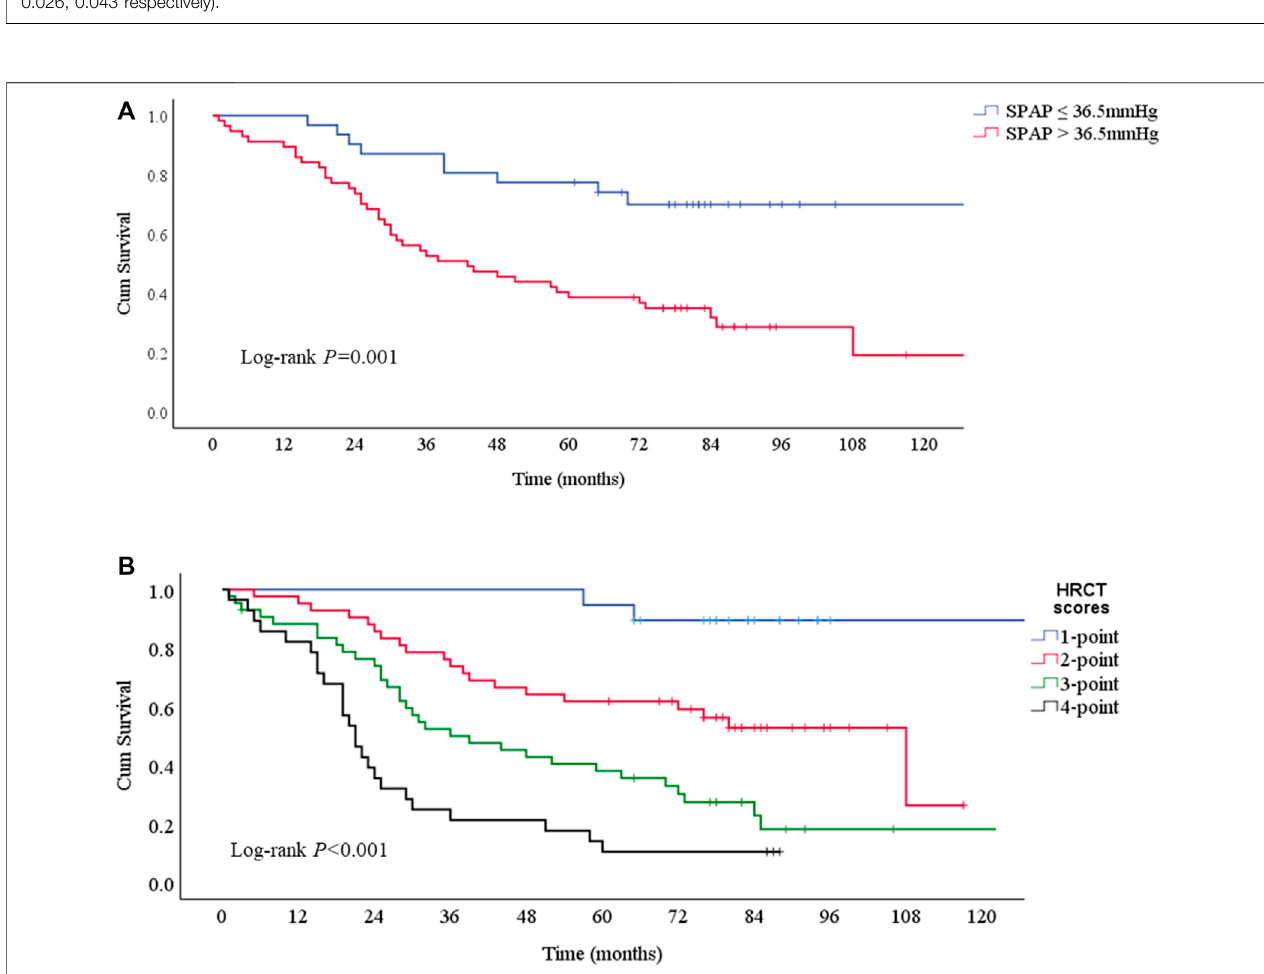
FIGURE 5 | Survival curves according to risk factors for mortality (A) Survival curves according to SPAP with a 36.5 mmHg threshold. Log-rank p (cid:1) 0.001. The mediansurvivaltimeswere43(95%CI:23-63) monthsinSPAP > 36.5 mmHggroupandNAinSPAP ≤ 36.5 mmHggroup (B) SurvivalcurvesaccordingtoHRCTscores. Log-rank p < 0.001. The median survival times were 108 (95%CI: 68-148) months in 2-point group, 39 (95%CI: 20-58) months in 3-point group, 21 (95%CI:17-25) months in 4-point group, and NA in 1-point group.; Abbreviations: SPAP, systolic pulmonary artery pressure; HRCT: high-resolution computed tomography.